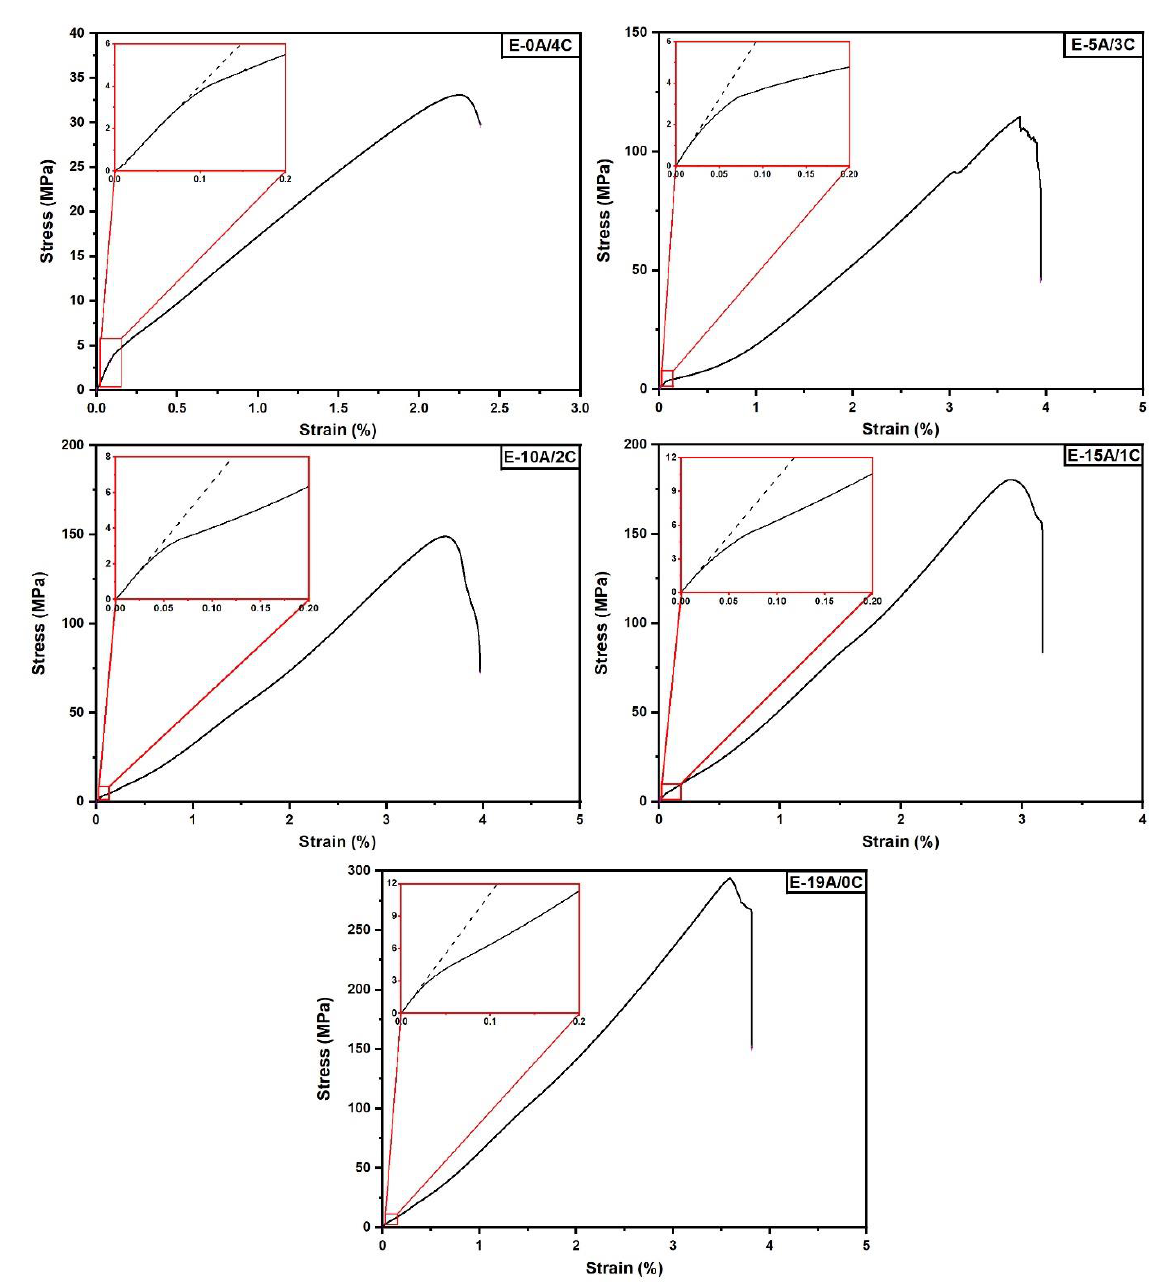
Figure 5. Typical stress-strain ( σ - ε ) curves obtained from the composites’ tensile tests. Composite ultimate tensile strength (UTS), deformation at the rupture ( ε rup ), elastic